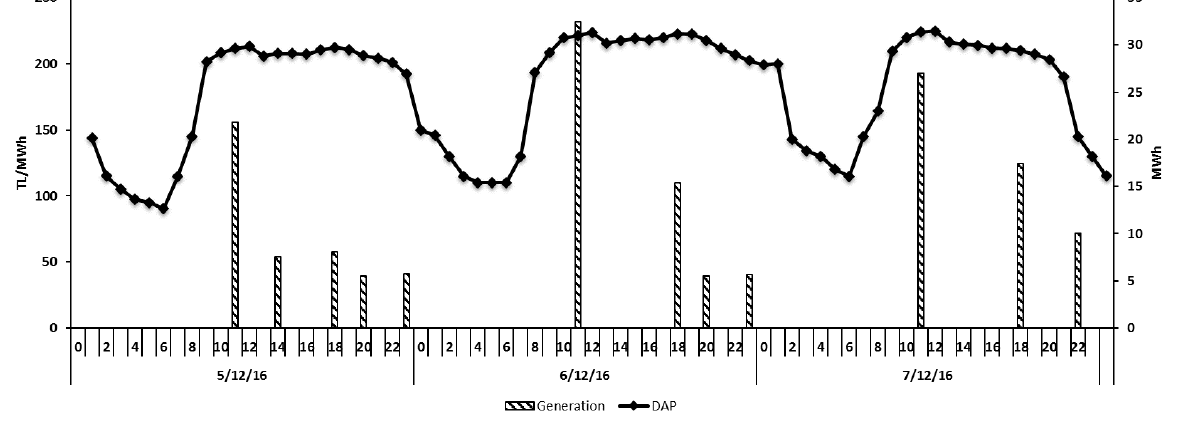
Fig. 6. Optimized dispatch schedule for the given period